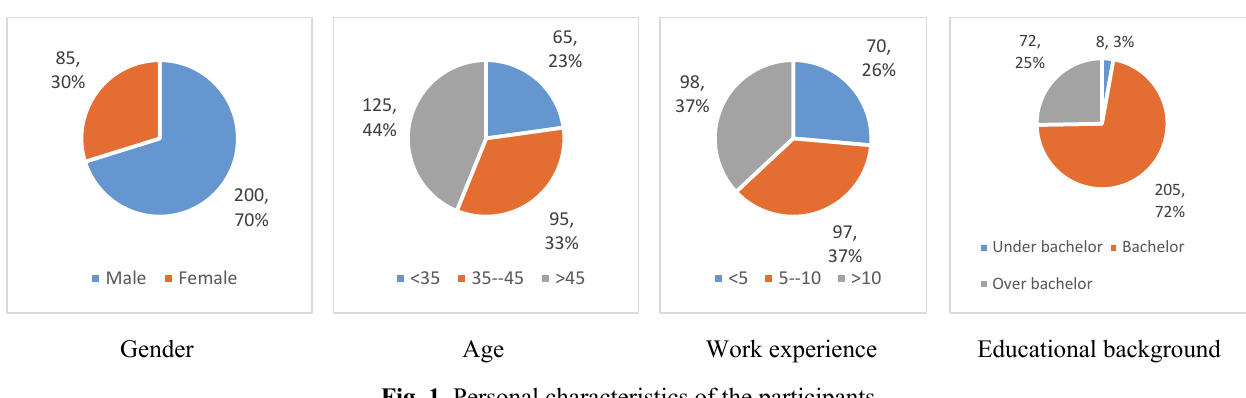
Results of reliability analysis and factor analysis